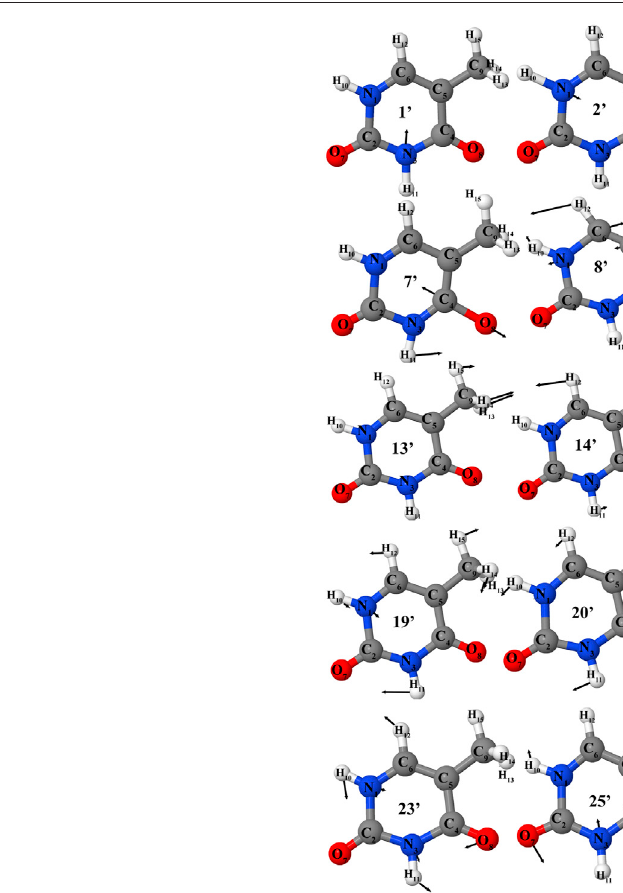
Figure 6. In general terms, the IR spectrum of T + is characterized by several bands of similar intensities, while the spectrum of T is dominated by strong transitions corresponding to bands dominated by CO stretching (assigned as ν (CO), β (cid:1) (NH)). The latter, the T ( X 1 A ′ ) 6 and 7 fundamentals, are over (cid:1) X 2 A ″ ) counterparts 6 ’ and four times more intense than their T + ( 7 ’ with intensity differences of -401.7 km/mol and -184.7 km/ pattern in the 1650 cm − 1 - 1850 cm − 1 range, which are in fl uenced changes, but also by different resonances. Both Figure 6B and Table 2 show that the peak at 1662 cm − 1 - 1664 cm − 1 of T is composed by 8 1 [ ν (C 5 C 6 ), β (C 6 H), β (N 1 H)] fundamental and a very close-lying 23 1 17 1 combination transition. Only the 8 1